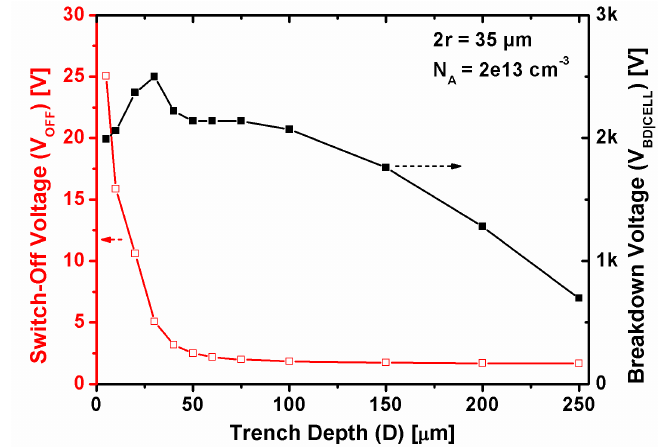
Figure 2. Simulated switch-off voltage, V OFF , ( red curves ) and inner-cell breakdown voltage, V BD|CELL , ( black curves ) as a function of the trench depth, D , for a given V-JFET cell with 2 r = 35 µm, N A = 2 × 10 13 at/cm 3 , and T = 300 µm.